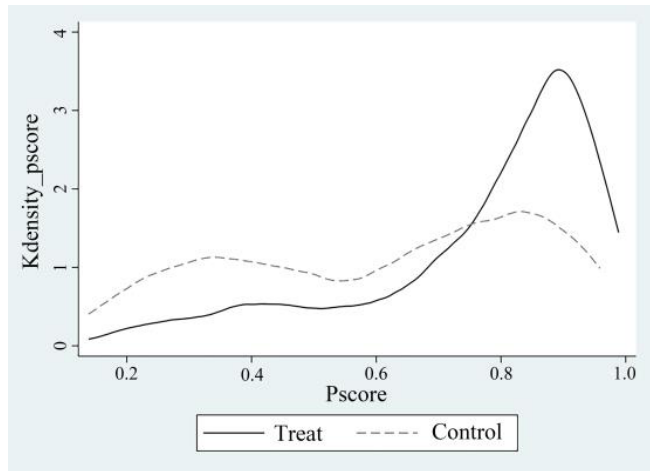
Figure 5. Propensity score density distribution after matching.